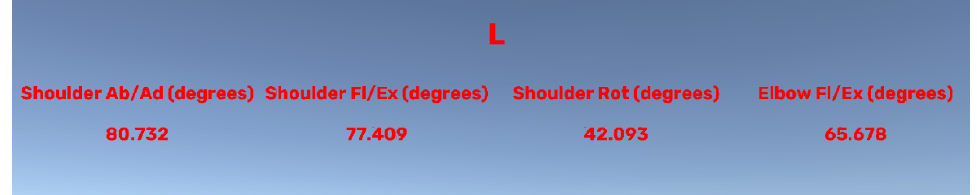
Figure 8. In-game text displaying the ROM of the upper limb joints’ DoFs while a user is playing the game in Figure